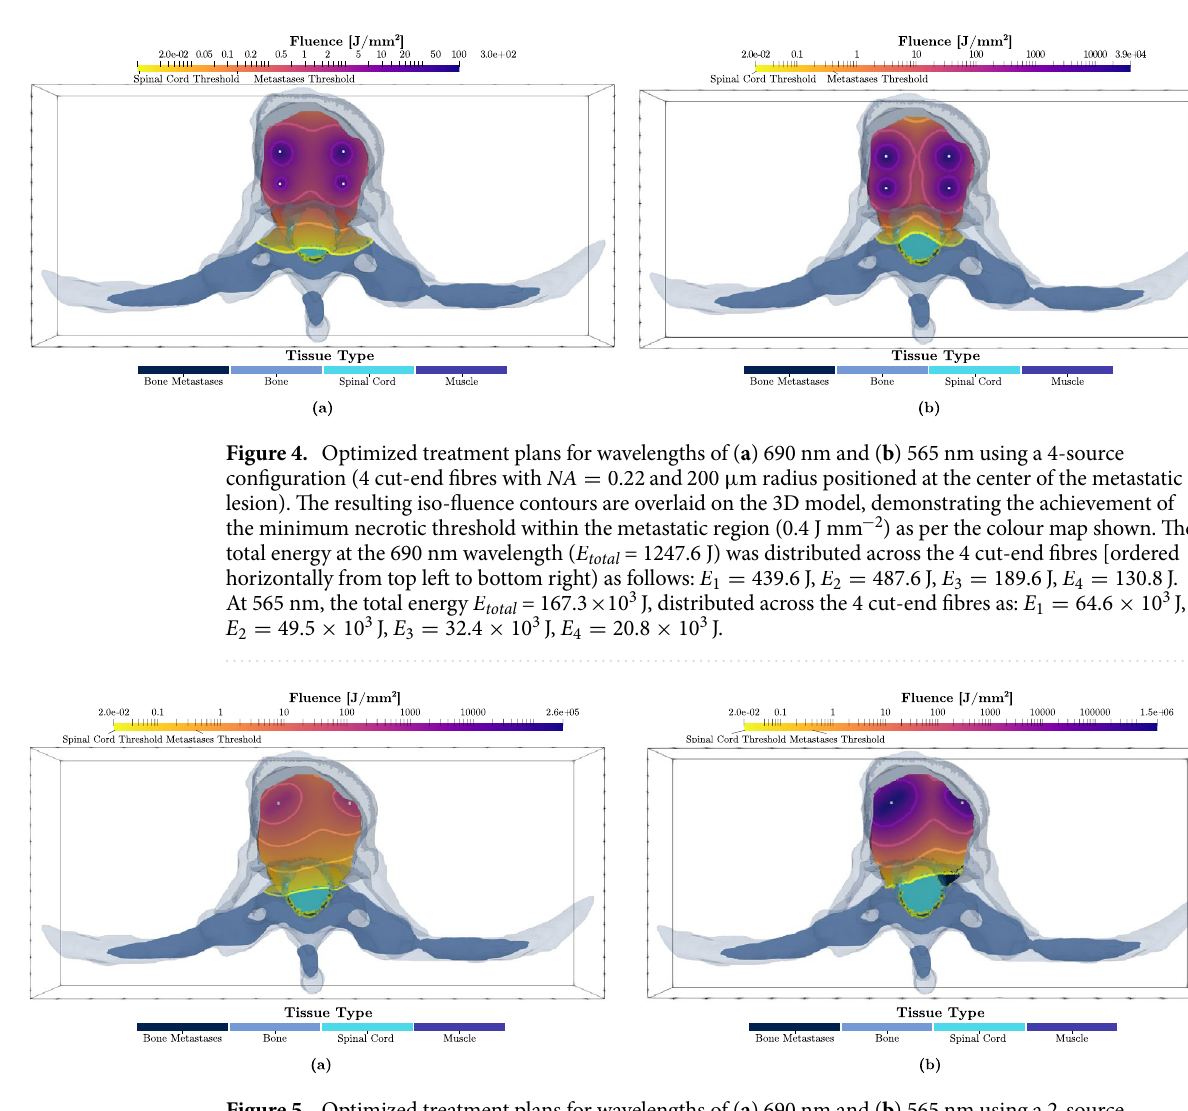
Figure 5. Optimized treatment plans for wavelengths of ( a ) 690 nm and ( b ) 565 nm using a 2-source configuration (2 cylindrical diffusers with a radius of 500 µ m). The resulting iso-fluence contours are overlaid − 2 on the 3D model, highlighting the the minimum necrotic threshold within the metastatic region (0.4 J mm ) as per the colour map shown. The total energy at the 690 nm wavelength ( E total = 2914 J) was distributed across the 2 light-emitting cylinders as: E 1 = 1981.8 J and E 2 = 932.4 J, for the left and right sources respectively. 6 6 6 At 565 nm, the total energy was E total = 9.3 × 10 J, distributed as: E 1 = 8.35 × 10 J and E 2 = 0.95 × 10